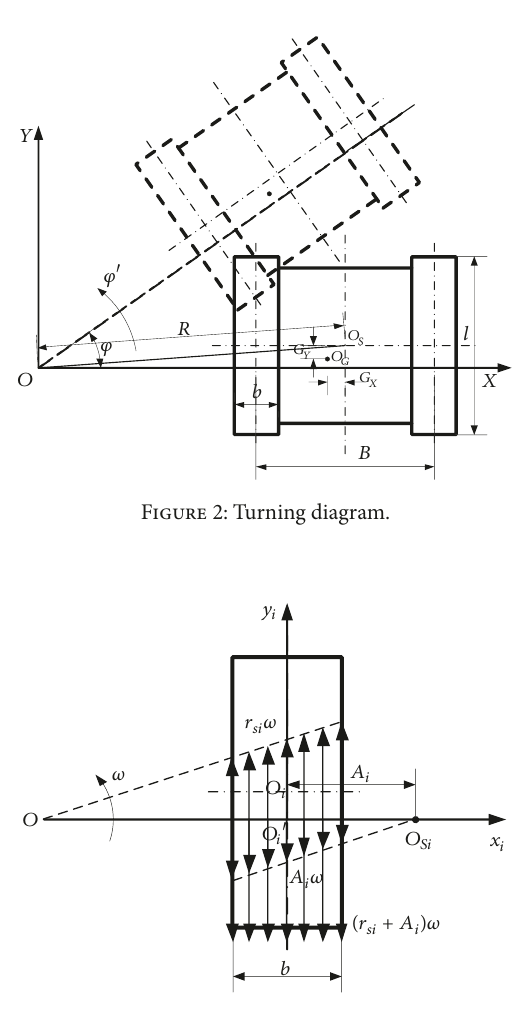
Figure 3: Velocity analysis of the